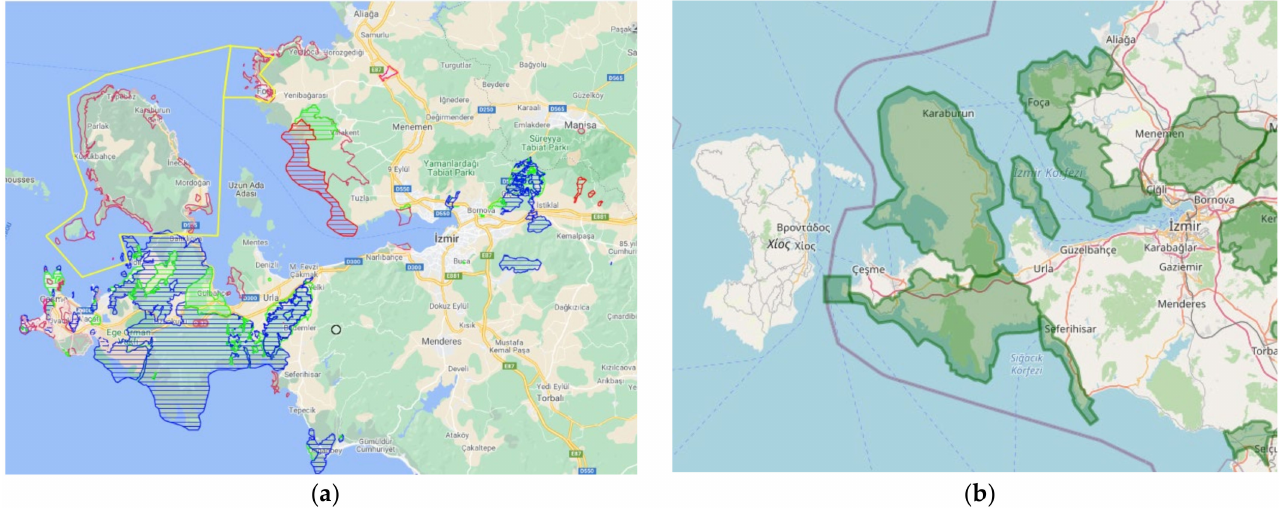
Figure 4. ( a ) Regulated Protection Areas in Izmir (1), ( b ) Key Biodiversity Areas in the AoI (2).